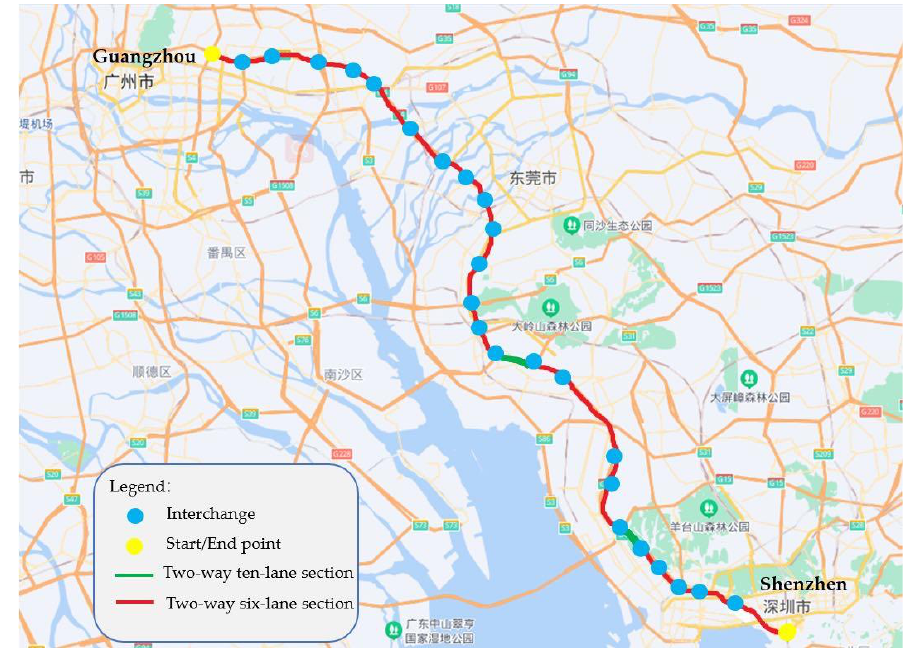
Figure 1. The Guangzhou-Shenzhen freeway.